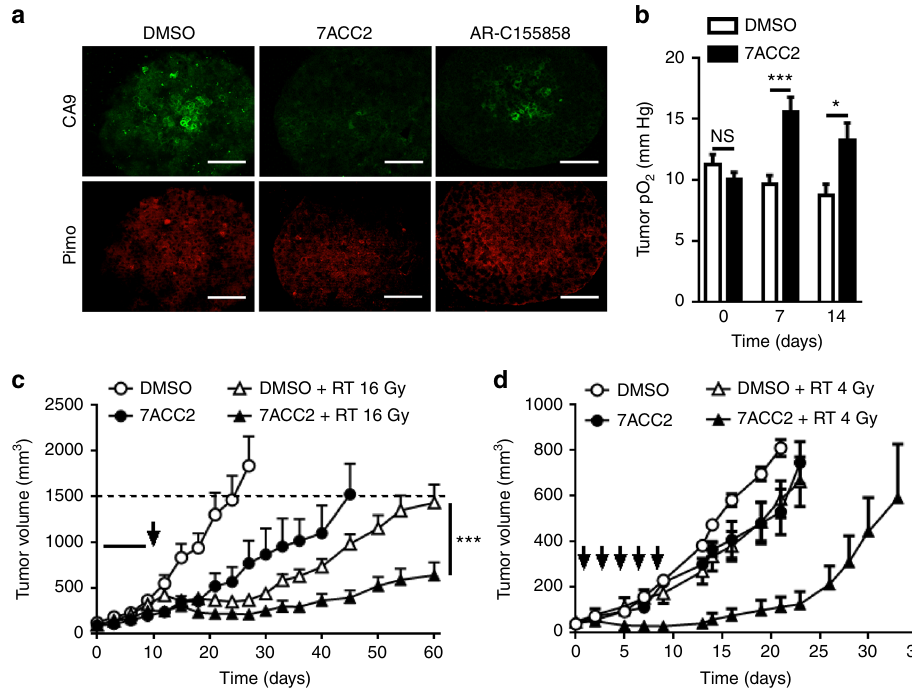
Fig. 6 Inhibition of mitochondrial pyruvate transport radiosensitizes tumor cells by reducing hypoxia in vivo. a Representative immuno fl uorescent pictures of CA9 and pimonidazole stainings in FaDu spheroids treated with 20 µ M 7ACC2 or AR-C155858 for 5 days. Scale bars: 100 µ m. b Tumor pO 2 measurements by EPR oximetry in SiHa xenografts treated with 3 mg/kg 7ACC2 for the indicated period of time ( n = 5 for each group). c , d Tumor growth of SiHa xenografts in nude mice daily treated with 3 mg/kg 7ACC2 (for 10 and 5 days in c and d , respectively) followed (or not) by a single irradiation of ( c ) 16 Gy or ( d ) 5 fractions of 4 Gy; arrows indicate the days of irradiation ( n = 7 for each group). 7ACC2 was formulated in DMSO ( c ) or in 5% DMA/ 50% HP β CD/45% sodium phosphate buffer ( d ). Data are represented as mean ± SEM. Signi fi cance was determined by Student ’ s t- test ( c ), or two-way ANOVA ( b ) with Bonferroni multiple-comparison analysis. * p < 0.05; *** p < 0.001; NS, not signi fi